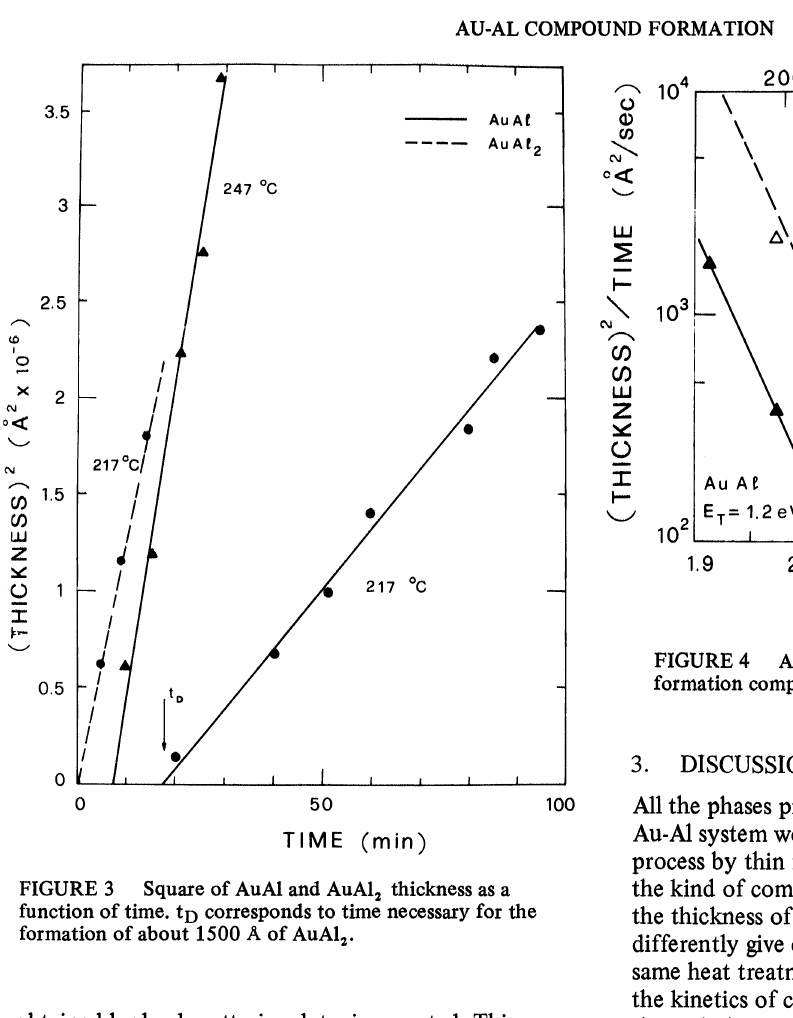
Square of AuA1 and AuA12 thickness as a function of time. D corresponds to time necessary for the formation of about 1500 A of AuA12.